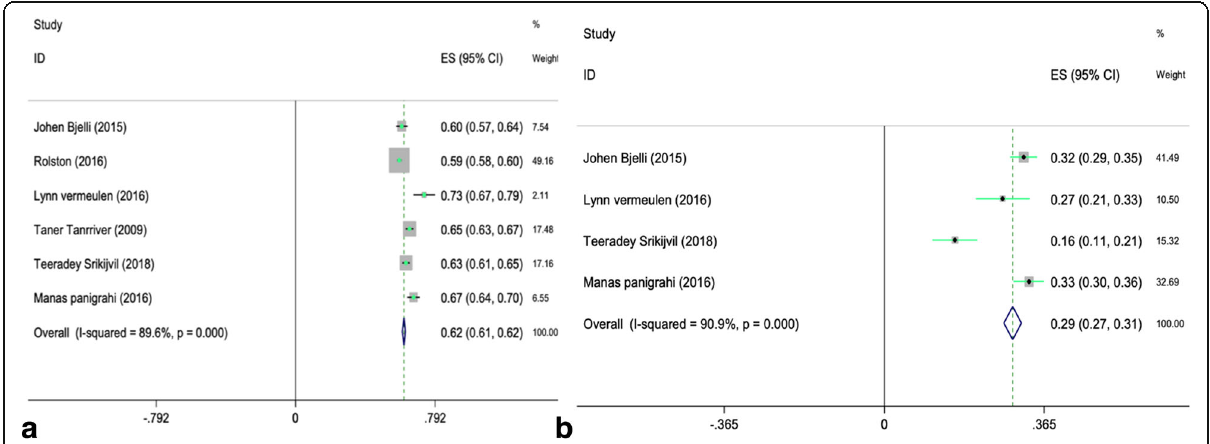
Fig. 4 The overall prevalence of temporal ( a ) and extra temporal ( b ) epilepsy surgery